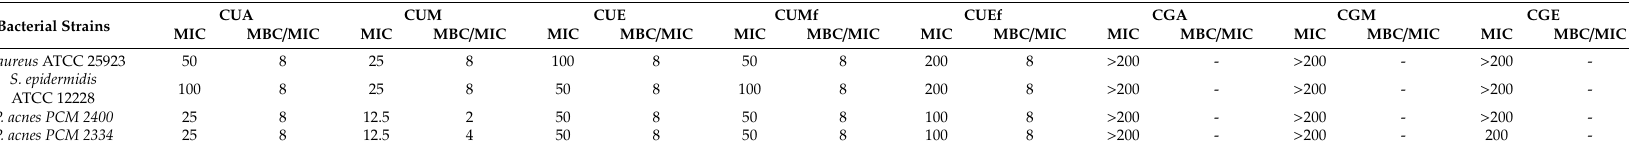
Table 5. Minimum inhibitory concentration (MIC [ µ g / mL]) and MBC / MIC ratio as an antibacterial activity of the tested C. uralensis and C. gigantea extracts. CUA CUM CUE CUMf CUEf Bacterial Strains